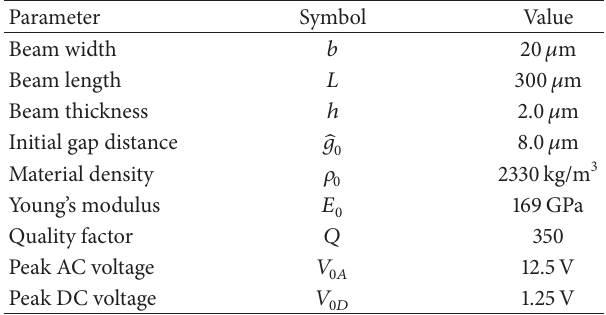
Table 1: Physical characteristics of a typical microbeam.